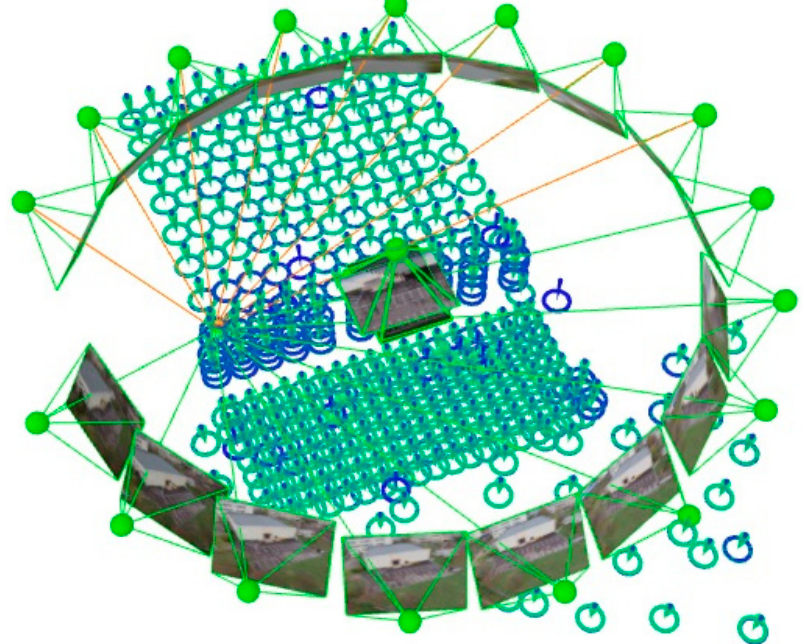
Figure 9. The elements resulted after the bundle adjustment process: cameras positions and orientations, GCPs positions and errors marked with green arrow.